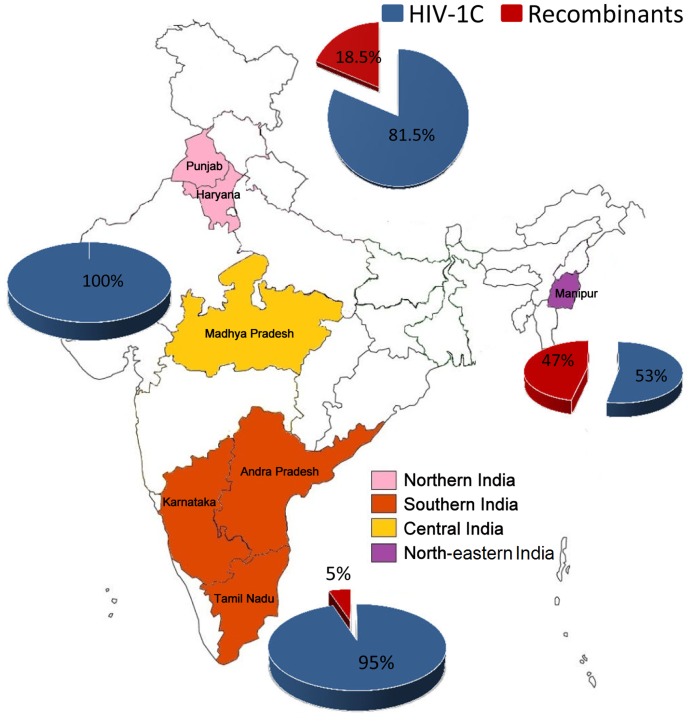
Distribution of HIV-1 subtypes and recombinants in the clinical cohorts based on two genes.The regions [southern (Karnataka, Tamil Nadu and Andhra Pradesh), northern (Punjab and Haryana), north-eastern (Manipur) and central (Madhya Pradesh)] from where the samples were collected are shown in colors. The pie chart depicts the percentage of subtypes and recombinant strains in respective regions.